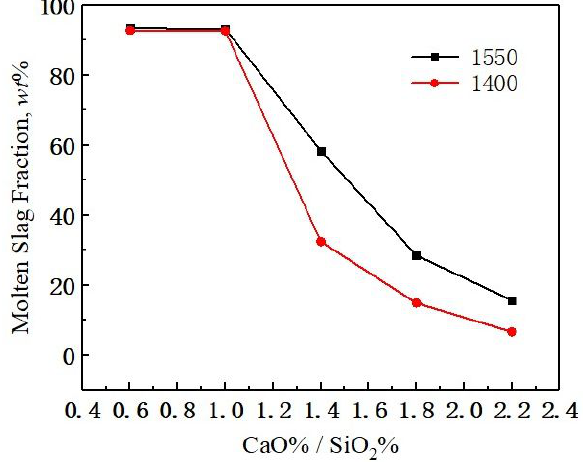
Figure 7: Relationship between the mass ratio of residual liquid phase and basicity at 1400 ∘ C and 1550 ∘